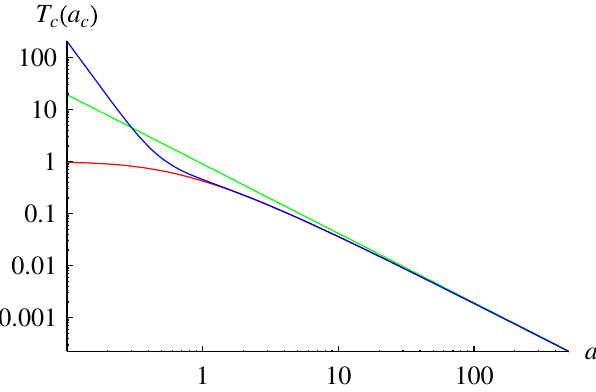
FIG. 17. (Color) The coherence function T c ð a c Þ of Eq. (79) is plotted in red. The green curve is the first term in the asymptotic expansion in Eq. (80) [13], and the blue curve uses all three terms in Eq.